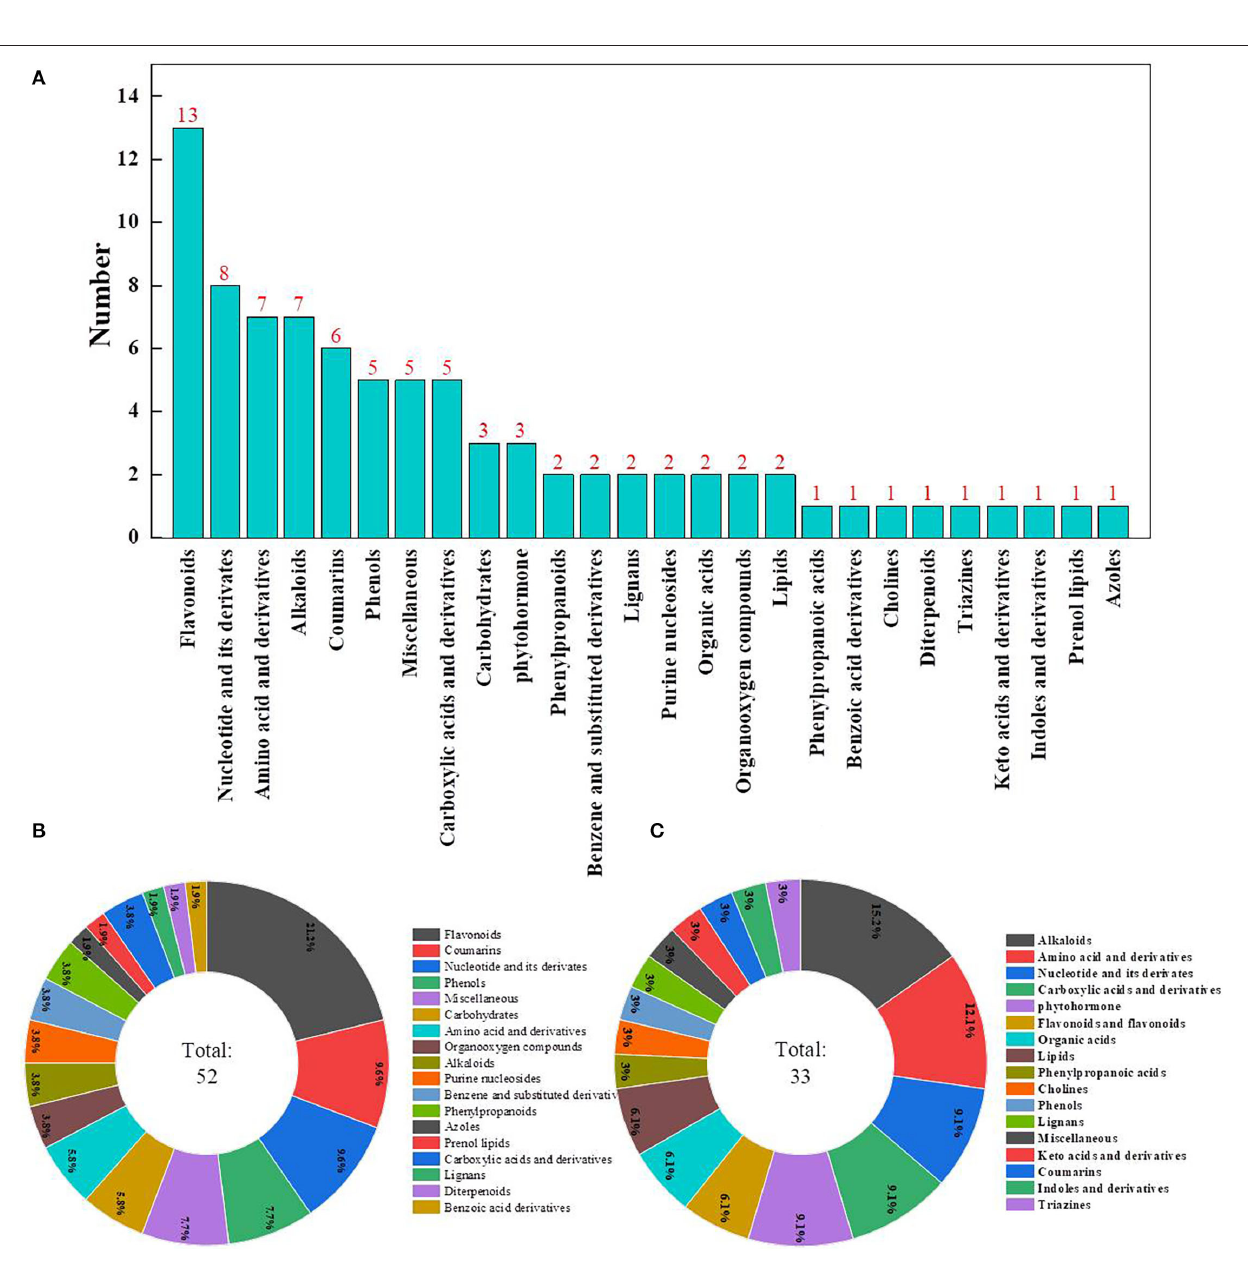
( Figure 7B ). Notably, additional control networks were identified ( Supplementary Figure 2